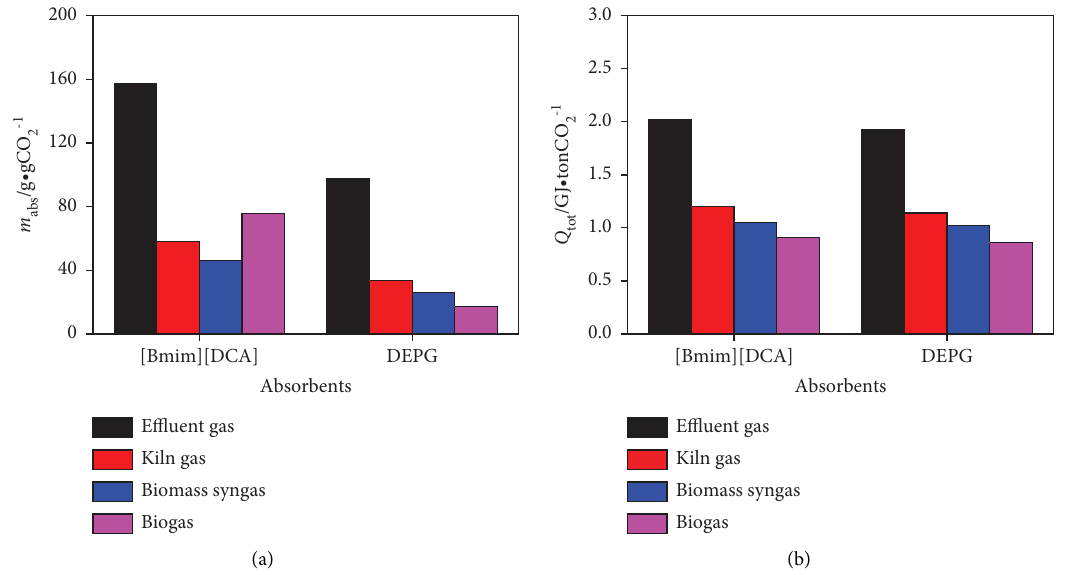
Figure 10: Te comparison of the performances of physical absorbents with P